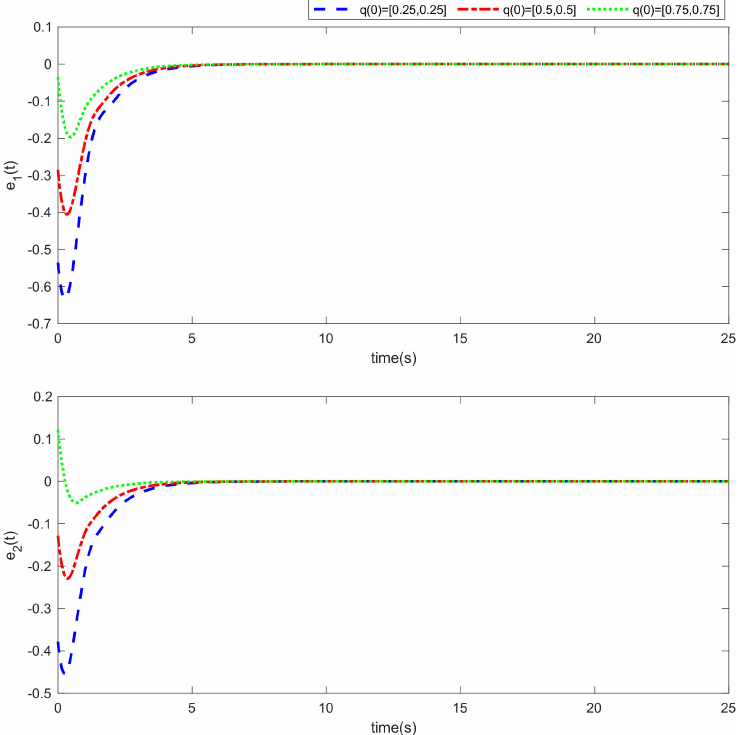
Figure 10. Time responses of the tracking error under different initial conditions (Example